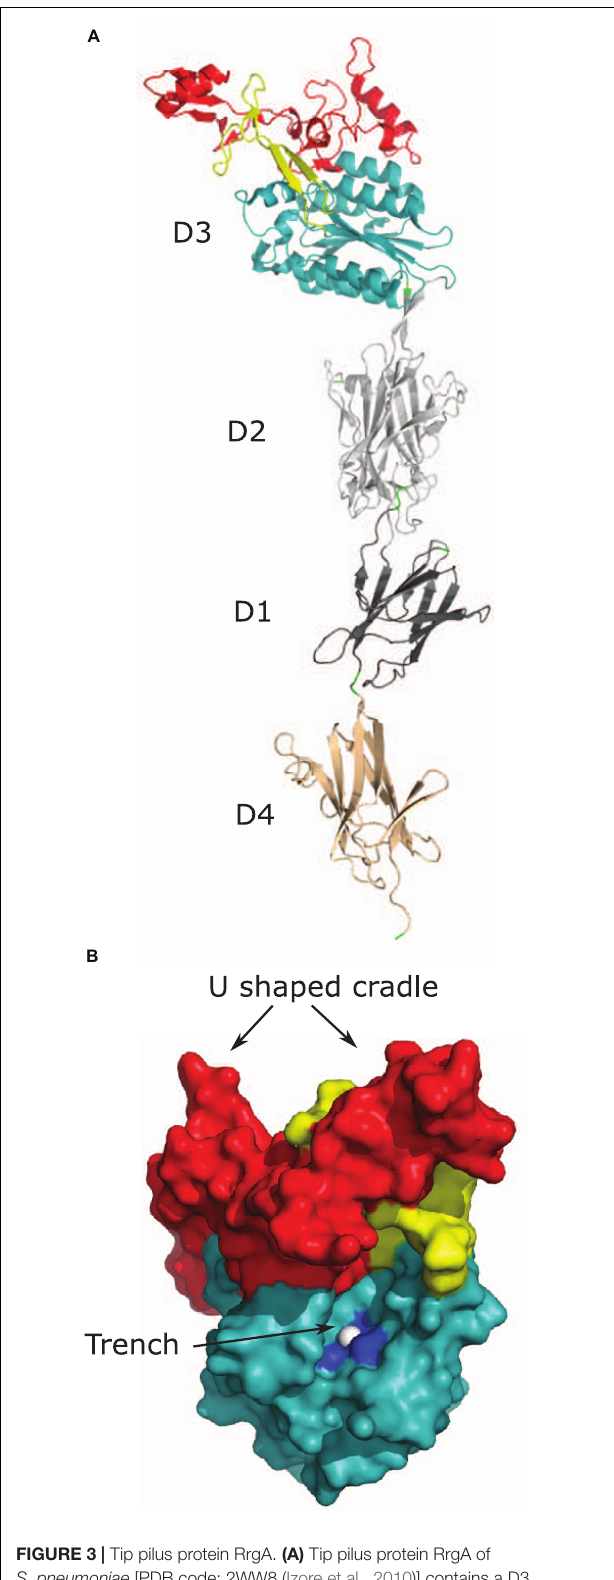
FIGURE 3 | Tip pilus protein RrgA. (A) Tip pilus protein RrgA of S. pneumoniae [PDB code: 2WW8 (Izore et al., 2010)] contains a